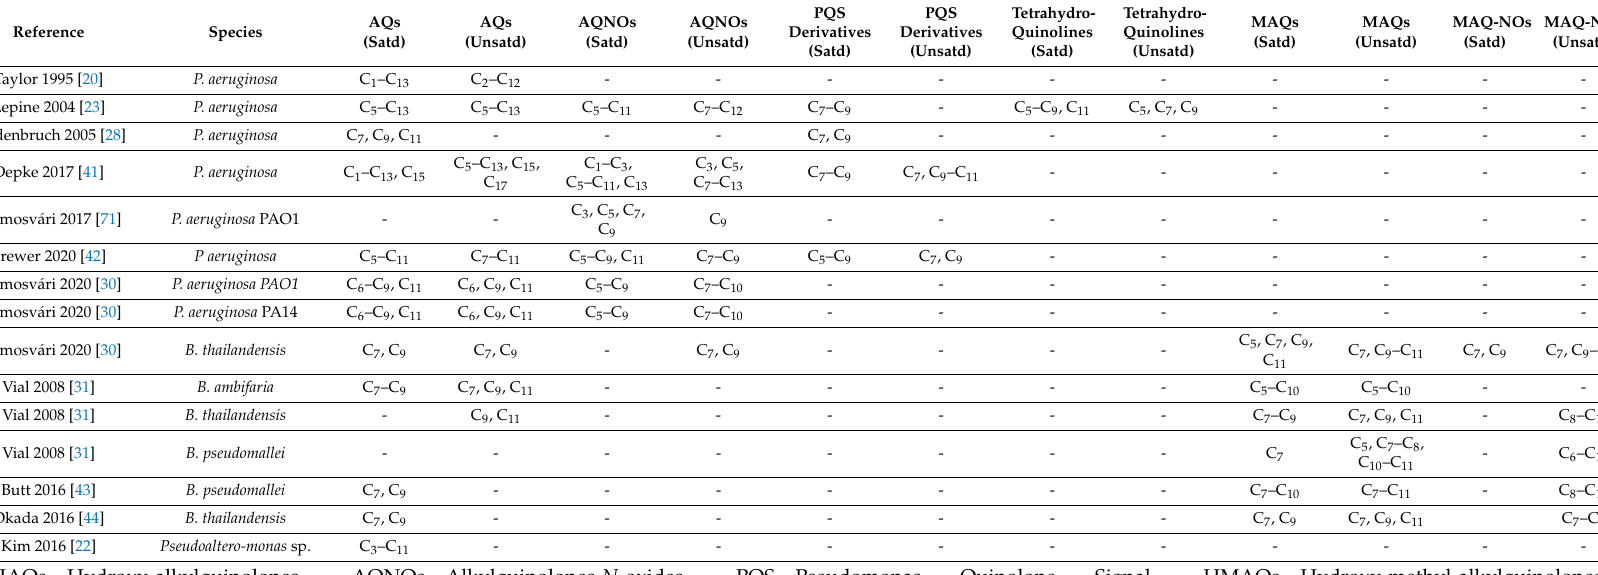
Table A3. Side-chain lengths of alkyl-4-quinolone derivatives detected during MS-based metabolic profiling of microbial